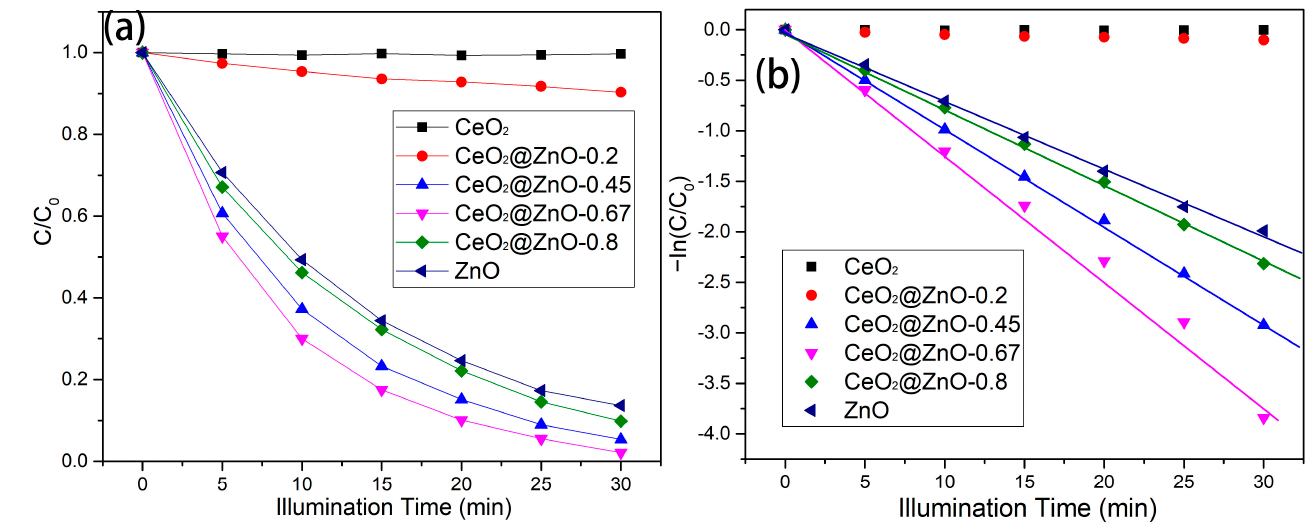
Figure 7. ( a ) Degradation efficiencies and ( b ) kinetic plots for the degradation of RhB over the CeO 2 , ZnO, and CeO 2 @ZnO nanocomposites during with respect to irradiation time. The experimental data were fi tt ed using the pseudo- fi rst-order kinetic model shown in Equation (2) [30,34].